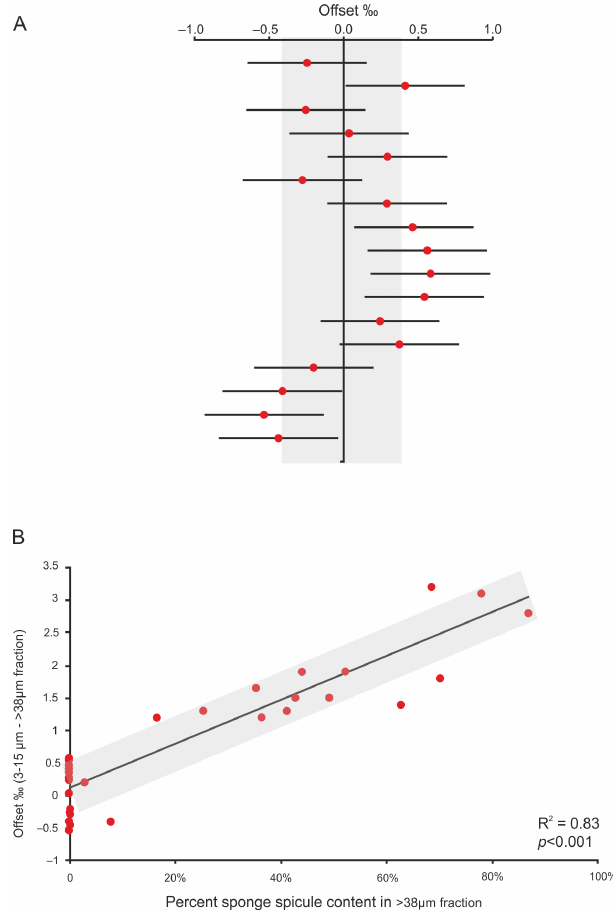
Figure 3. (a) The offset between the > 38µm and the 3–15µm fractions where no/negligible sponge spicules are present. The y axis represents sample points, not to scale. Shaded area represents ± 0.4‰ mean offset, and horizontal error bars for each point rep- resent the ± 0.4‰ analytical reproducibility. (b) The relationship between the sponge content (area ratio) of the > 38µm fraction and the offset between the δ 18 O of the diatom 3–15µm fraction and the mixed > 38µm